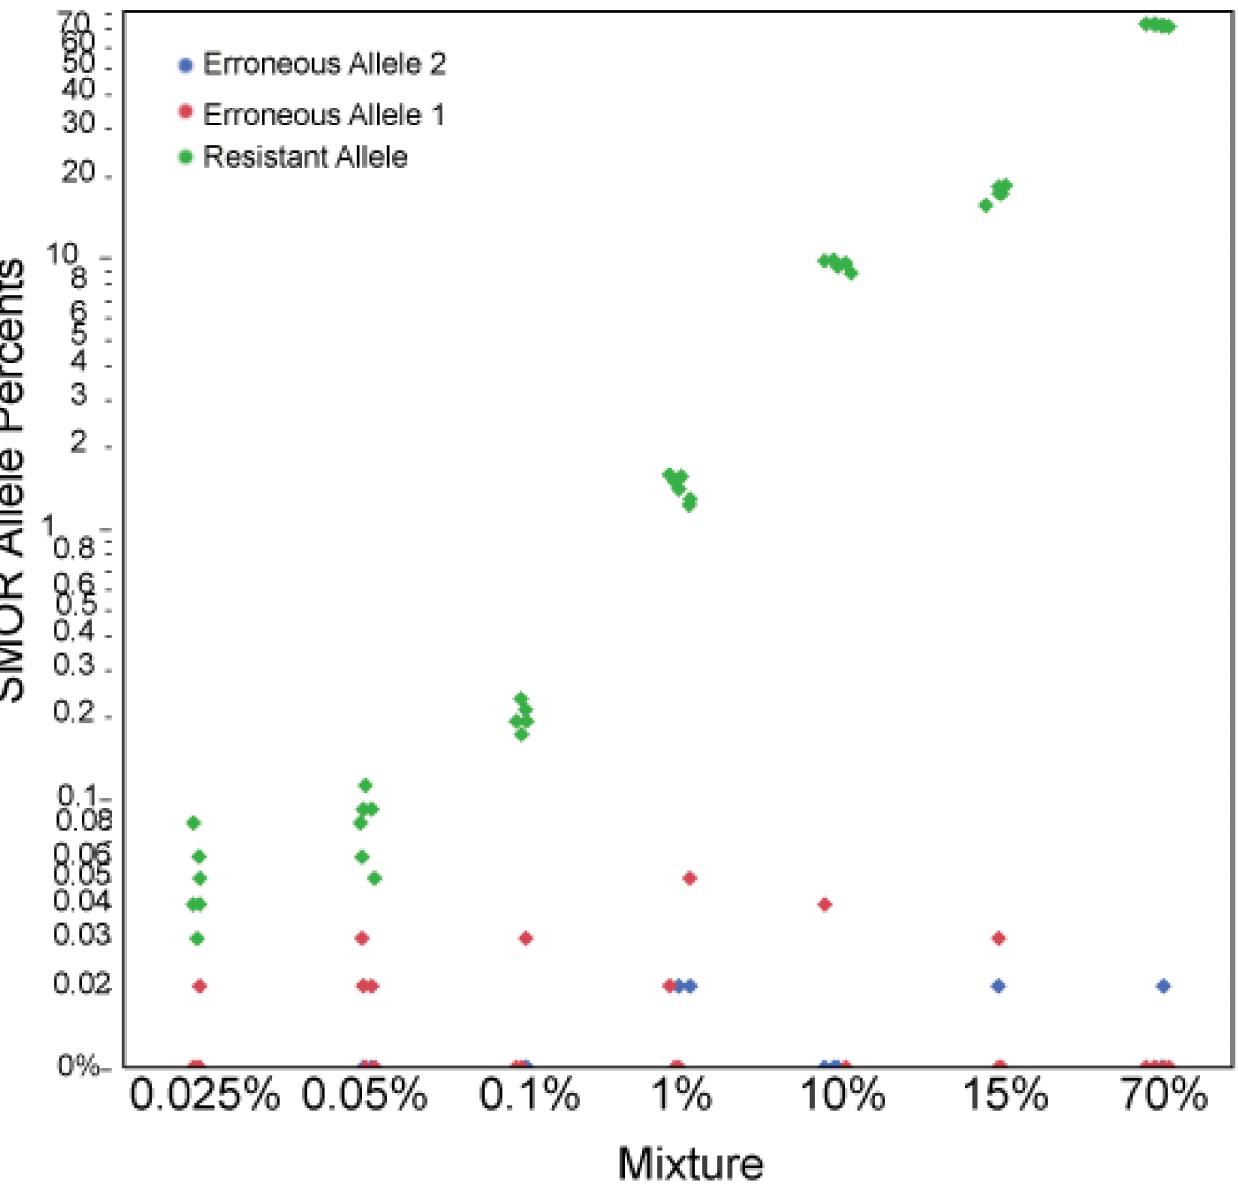
Fig 3. SMOR minor subpopulation examination of a single replicate of 7 mixtures at six known differing resistance SNP loci. Each circle represents the percent SMOR call, where color represents allele state, for a single sample at the six resistant SNP loci. All 36 SNP loci were examined; however the seven different mixtures contain six known allelic differences in resistant conferring SNP